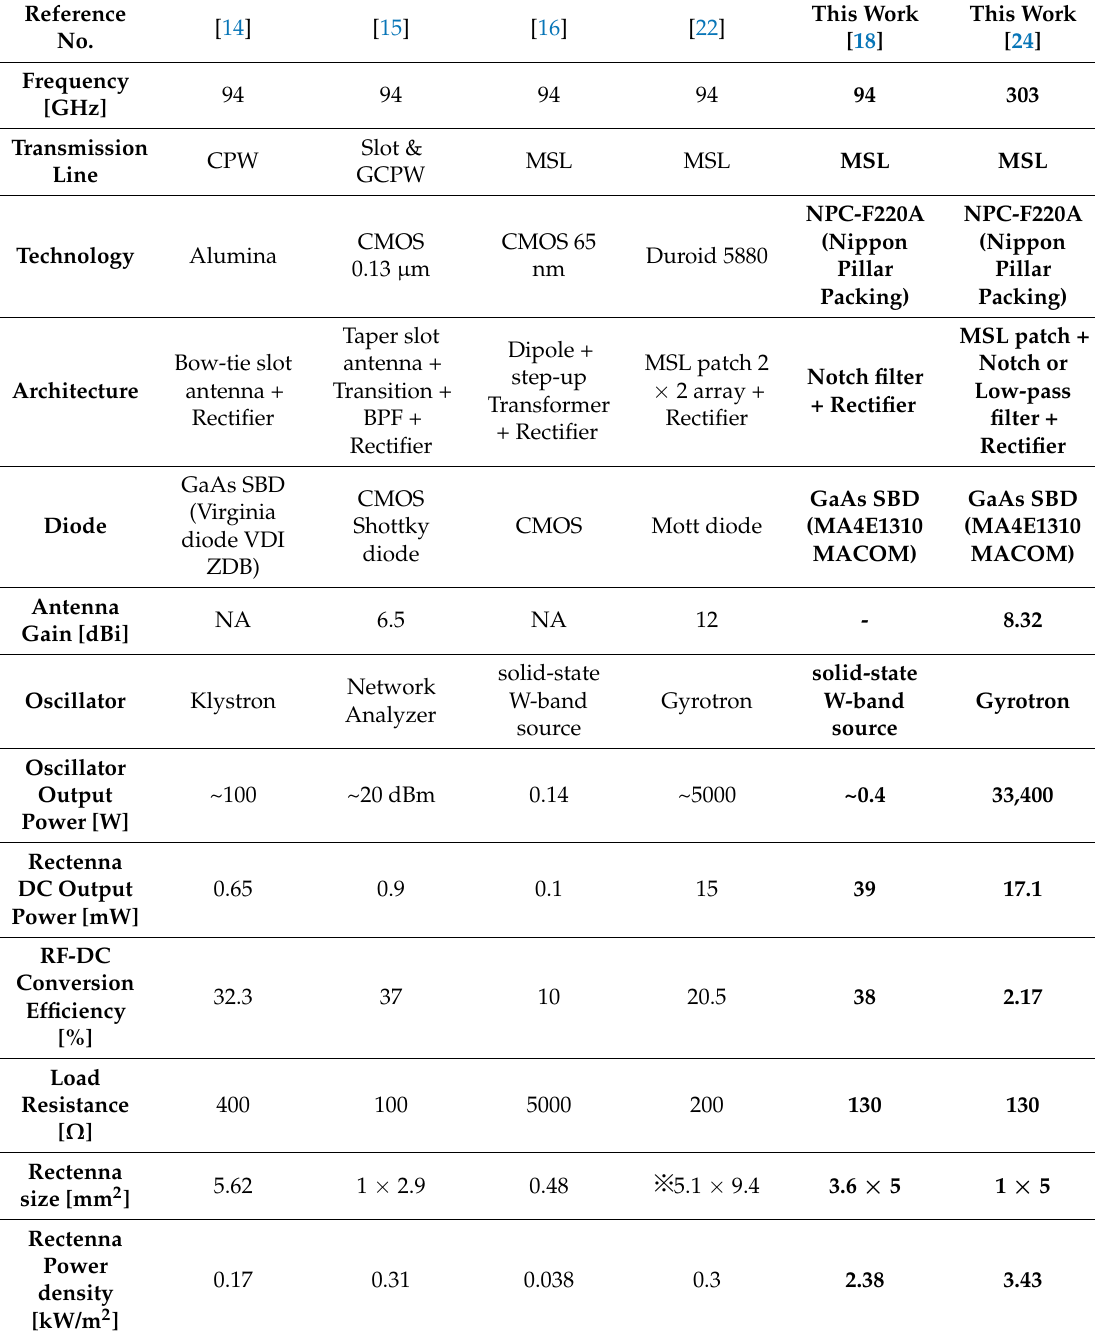
Table 3. Comparison of this work to earlier studies in W—mm